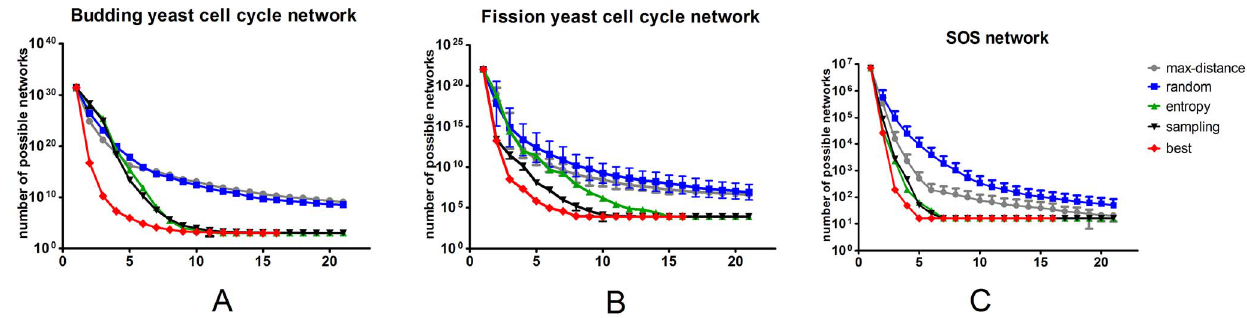
Figure 3. The performances of the three methods compared with random method and the best sequence. The best sequence is calculated by enumerating all the initial conditions. A, in budding yeast cell cycle network; B, in fission yeast cell cycle network; C, in E.coli SOS network.